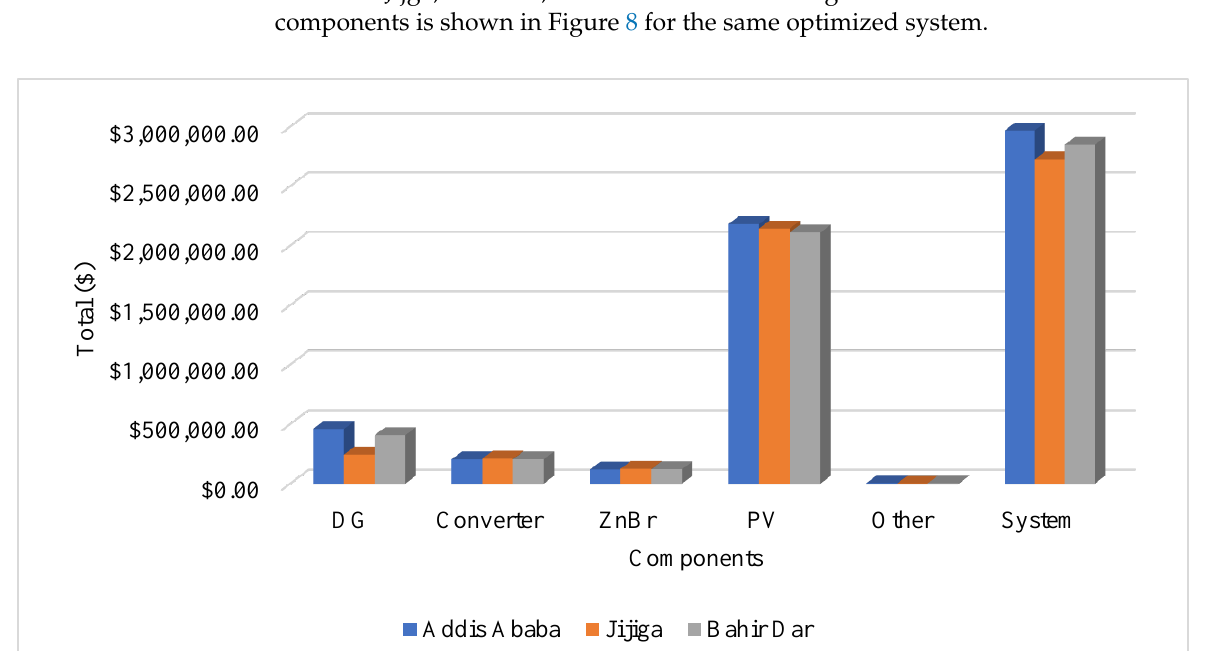
Figure 8. Cost summary of the PV/DG/ZnBr system. 3.2. Comparative Evaluation of Base Case and Optimal Hybrid Systems In this study, the sole diesel generator (DG) system is used as a baseline for evaluat- ing environmental variables. All the lowest values of NPC compared to base case and the last highest NPC from all the feasible systems in the three cities are shown in Figure 9a–c respectively. In the three cities, compared to the base case (DG) system, the PV/DG/ZnBr system provides the lowest NPC with values $2.97 M, $2.72 M and $2.85 M and COE with values $0.196, $0.18 and $0.188, while the WT/PV/LI, PV/LI, WT/PV/LI system has the maximum NPC and COE of all feasible systems in Addis Ababa, Jijiga and Bahir Dar respectively, as shown Figure 9a–c.